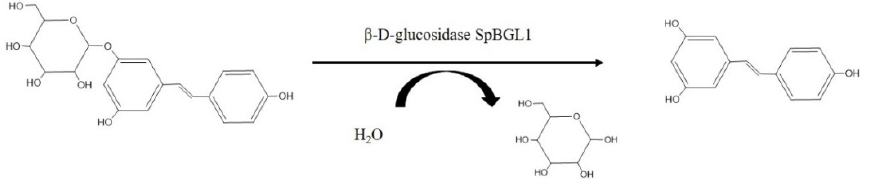
Figure 1. The conversion of polydatin into resveratrol by SpBGL1, a β -D-glucosidase from Sphin- gomonas sp. ATCC31555. One molecule of polydatin is hydrolyzed into one molecule of glucose and one molecule of resveratrol.